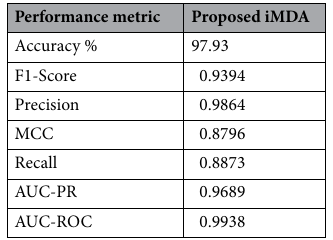
Table 3. Performance of the proposed model.